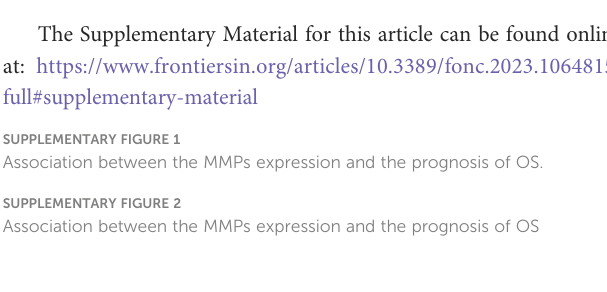
SUPPLEMENTARY FIGURE 1 Association between the MMPs expression and the prognosis of OS. SUPPLEMENTARY FIGURE 2 Association between the MMPs expression and the prognosis of